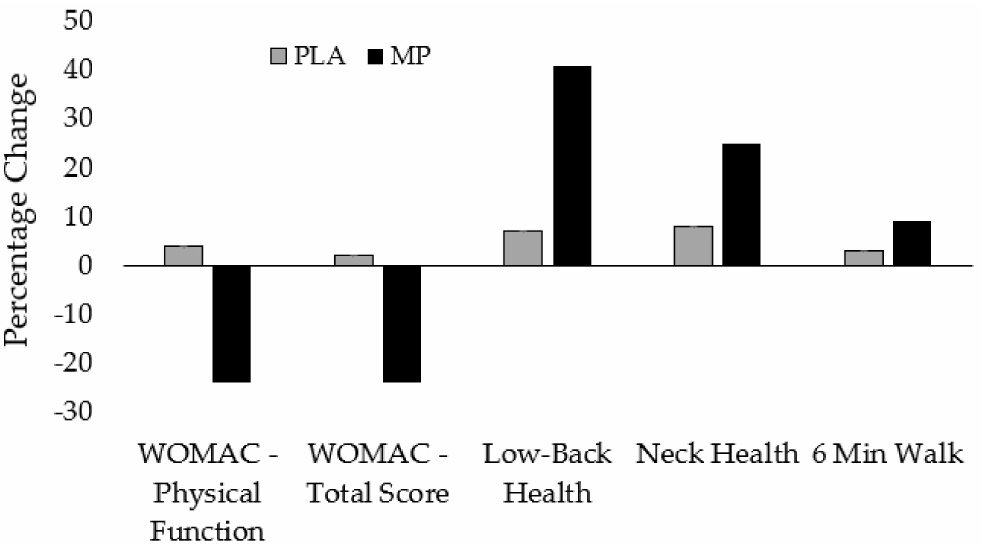
Figure 4. Percentage change in PLA and MP for WOMAC—Physical Function, WOMAC—Total Score, Low-Back Health, Neck Health and 6-Minute Walk Test Performance. Grey bars = PLA; Black bars = MP (proprietary milk protein